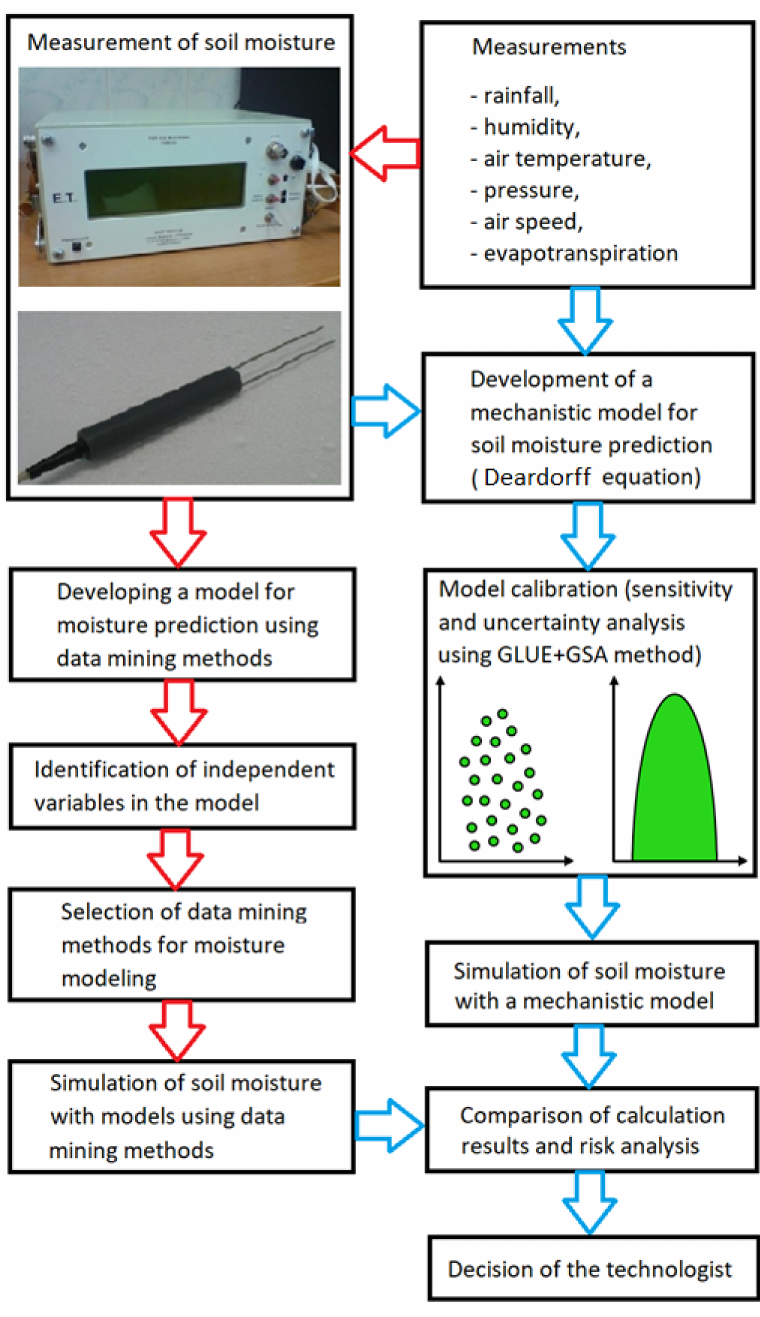
Figure 1. Algorithm for soil moisture model